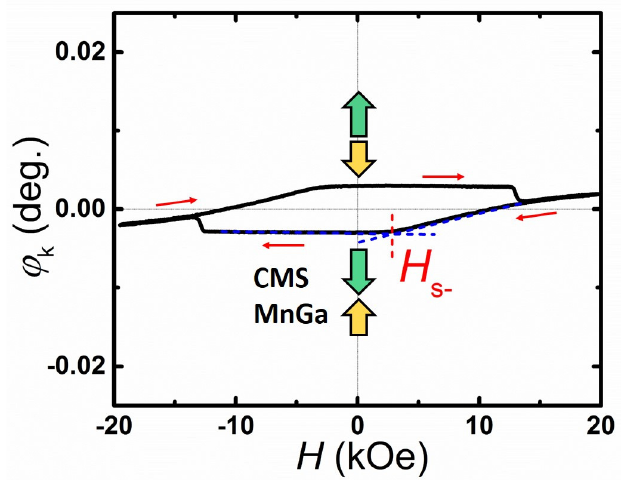
Figure 4. Polar Kerr hysteresis loop of the un-annealed CMS (5 nm)/MnGa (30 nm)